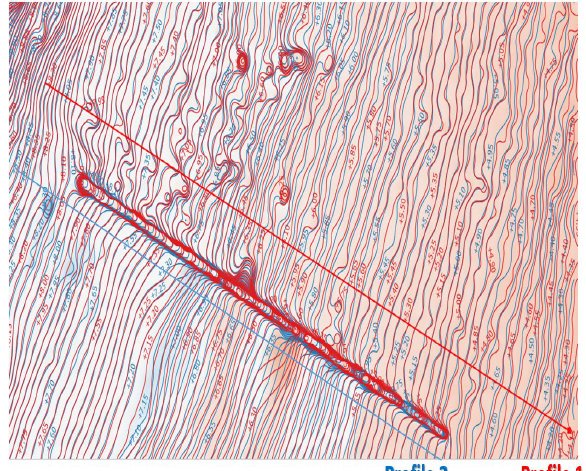
Figure 22a - Location of Two Profile Cross Sections (Profile 1 and Profile 2: North and South of the Groyne).